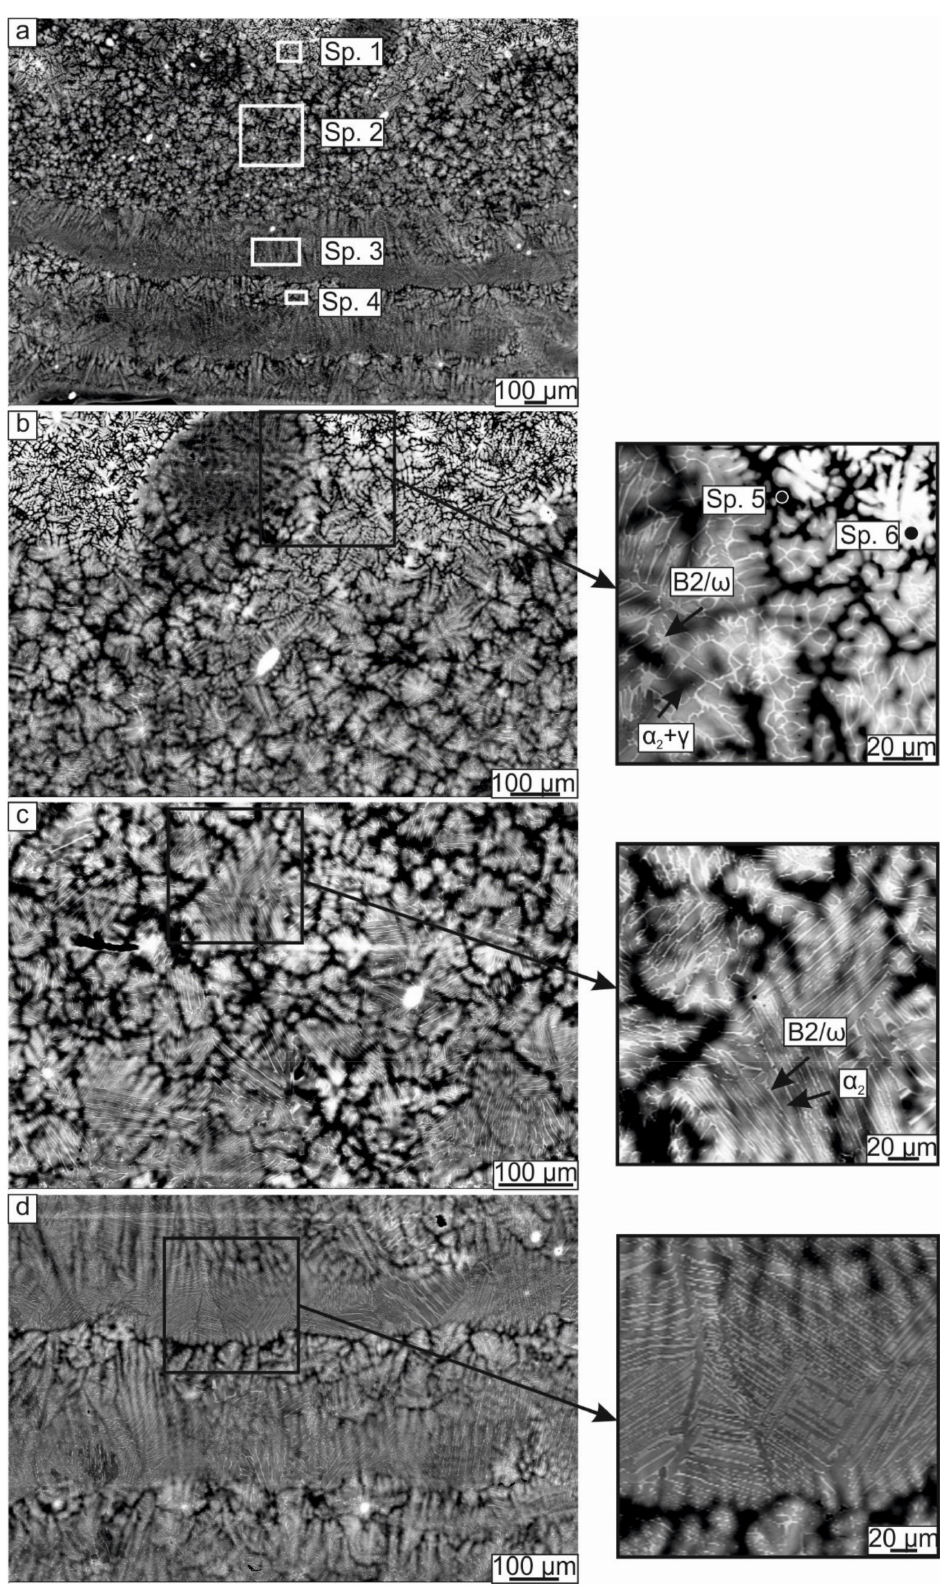
Figure 4. Microstructure of the Ti-41Al-7Ta cladding layer: ( a ) overview; ( b – d ) local areas of the cladding layer obtained in the direction from the surface of the cladding layer to the substrate. SEM images were obtained in backscattered electrons